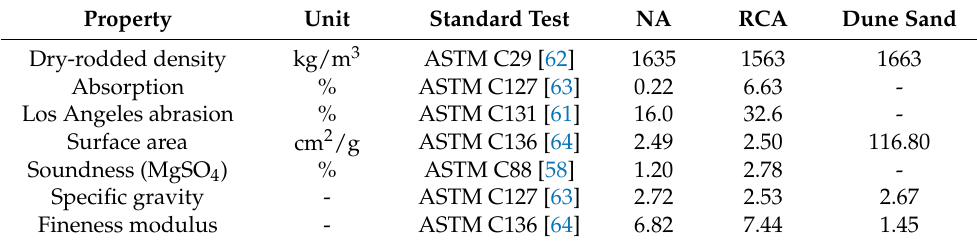
Figure 4. Particle size distribution of different mixtures of NA and RCA. Table 2. Physical properties of fine and coarse